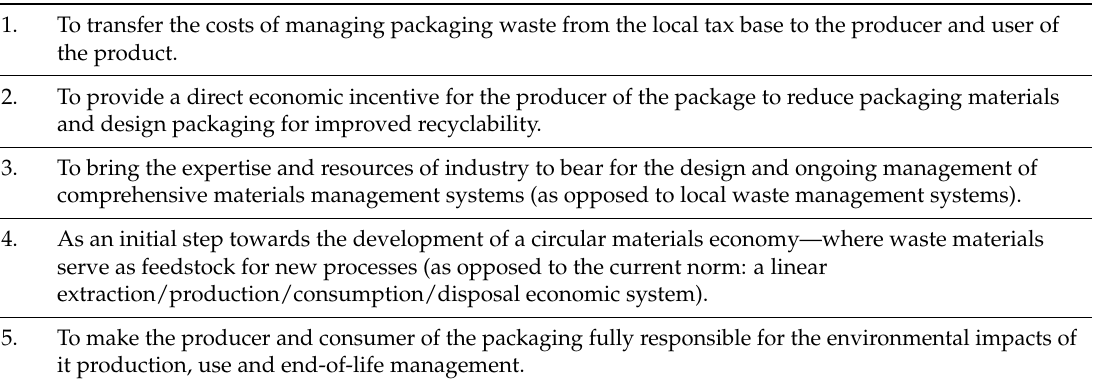
Table 1. Rational for extended producer responsibility